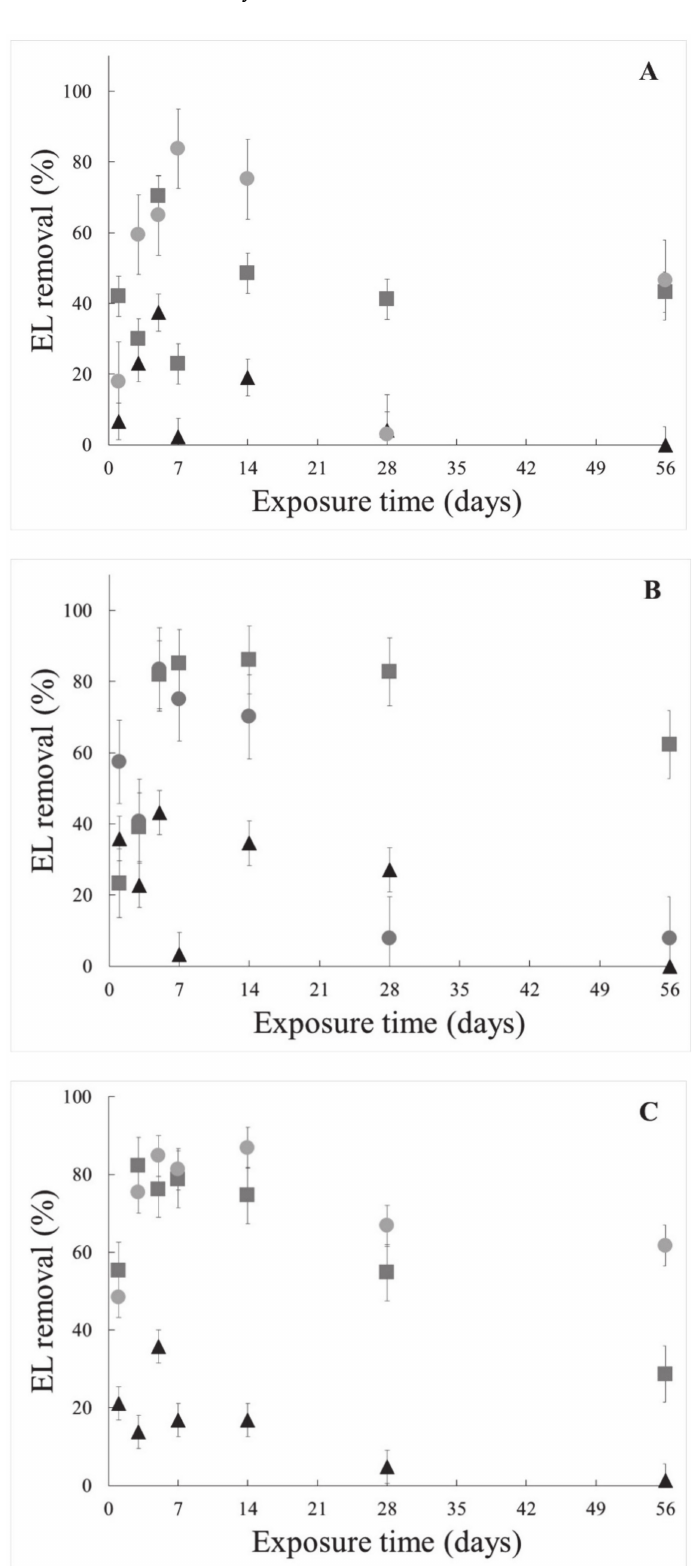
Figure 5. Endosulfan Lactone (EL) removal (%) on sterile solid substrate with ( A ) 0.001 mg/kg, ( B ) 0.004 mg/kg and ( C ) 0.009 mg/kg for zero ( (cid:78) ), five ( (cid:4) ) and ten ( • )